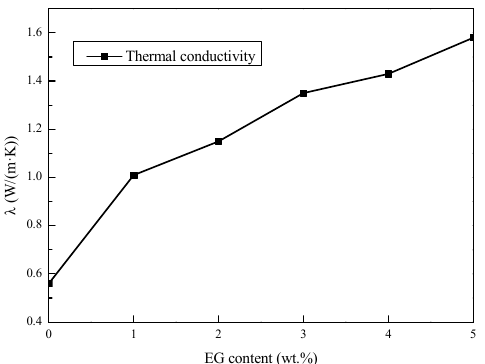
Figure 10. Thermal conductivities of the Na 2 SO 4 ·10H 2 O composites with varying contents of expanded graphite (EG).